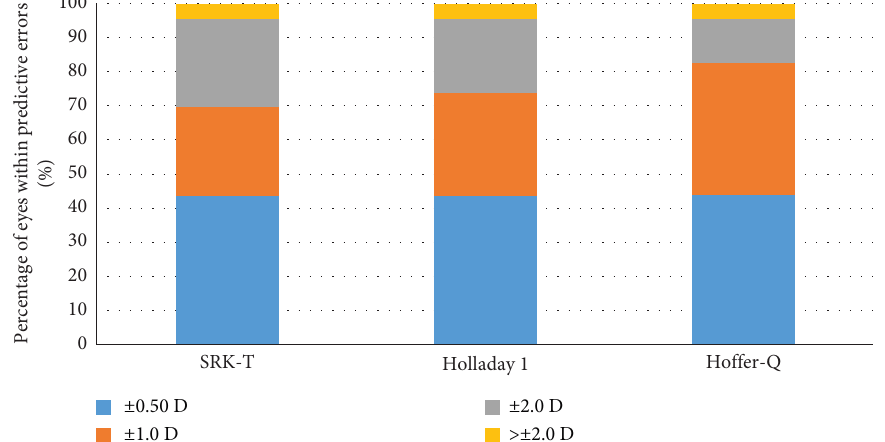
Figure 3: Stacked histogram comparing percentage of eyes within the certain refractive prediction errors of the 3 formulas.